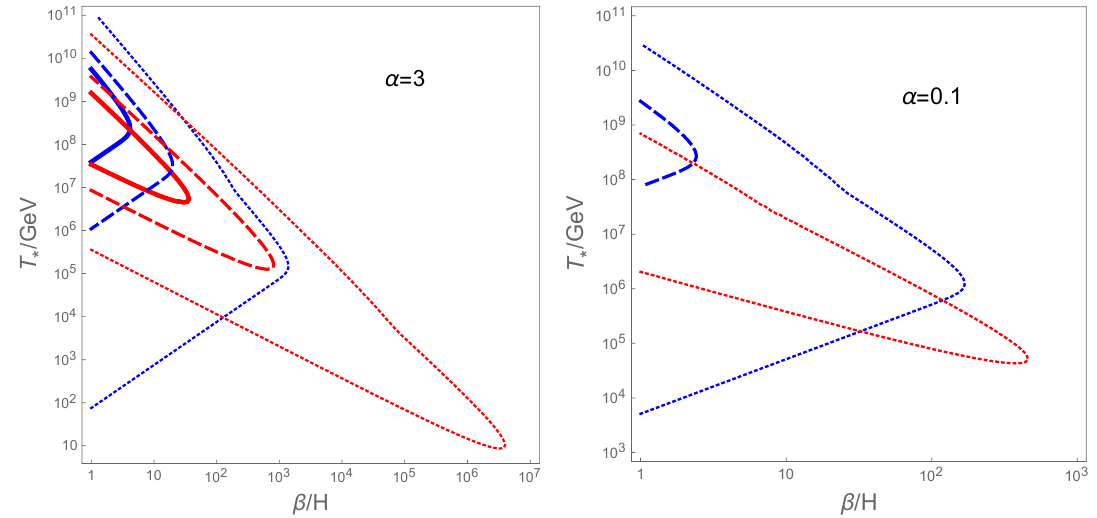
Figure 2 . Sensitivity lines for current LIGO (solid), LIGO at design sensitivity (dashed) and ET (dotted). Blue or red colors refer respectively to whether the signal is mainly sourced by bubble wall collisions (with (cid:20) (cid:30) = 1) or by sound waves (with (cid:20) sw given in (2.11)). The points to the left of the curves represent detectable signals. Left panel: (cid:11) = 3 and v w = 1. Right panel: (cid:11) = 0 : 1 and p v w = 1 =